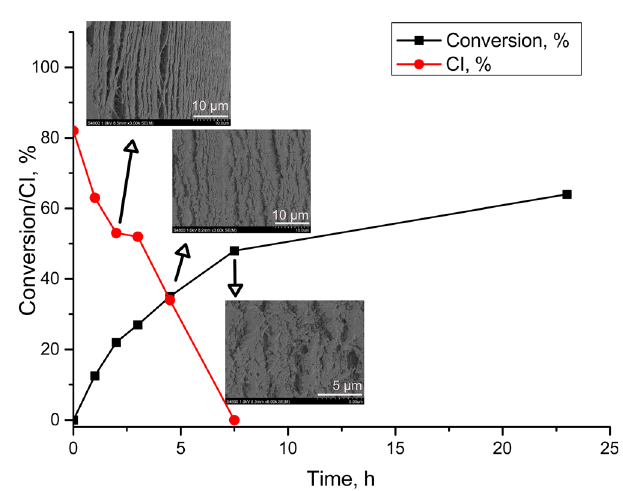
Fig. 2 | Oxidation of Holo-CNF wet cake using NaIO 4 solution (2.2g of NaIO 4 in 40mL H 2 O, ca. 250mg of Holo-CNF (dry weight)). Correlation between the reaction time, conversion (black squares), and crystallinity index (CI, red circles, Supplementary Fig. 37). SEM images of fracture surfaces of freeze-dried DA-CNF wetcakeswithdifferentdegreesofoxidation.SourcedataareprovidedasaSource Data fi